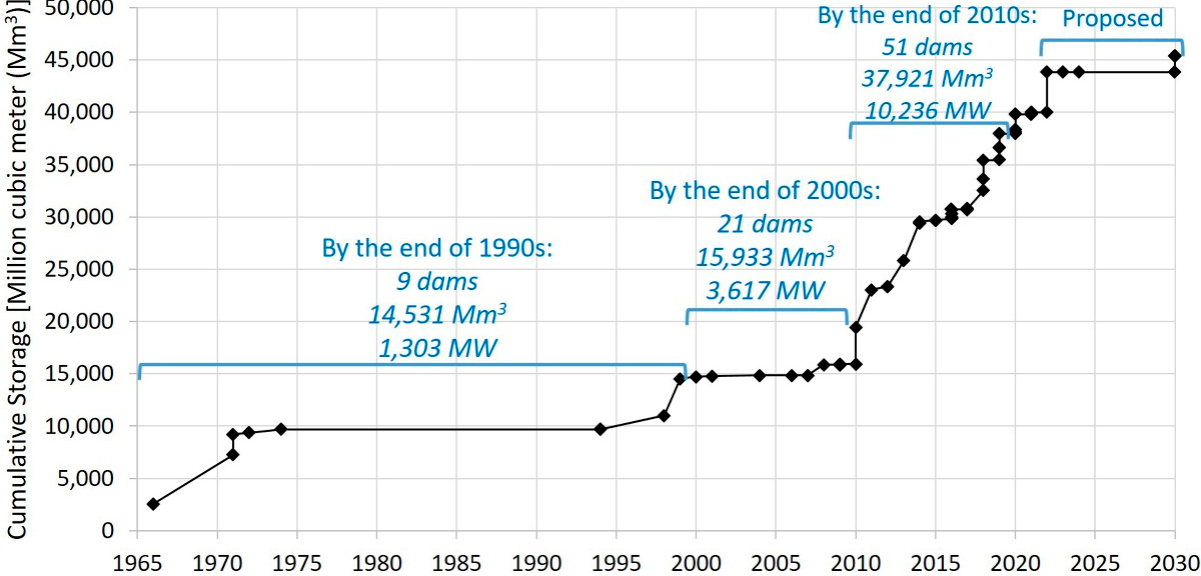
Figure 1. Hydropower dam development and cumulative storage and installed capacity in the Lower Mekong Basin. Data is derived from WLE [38].